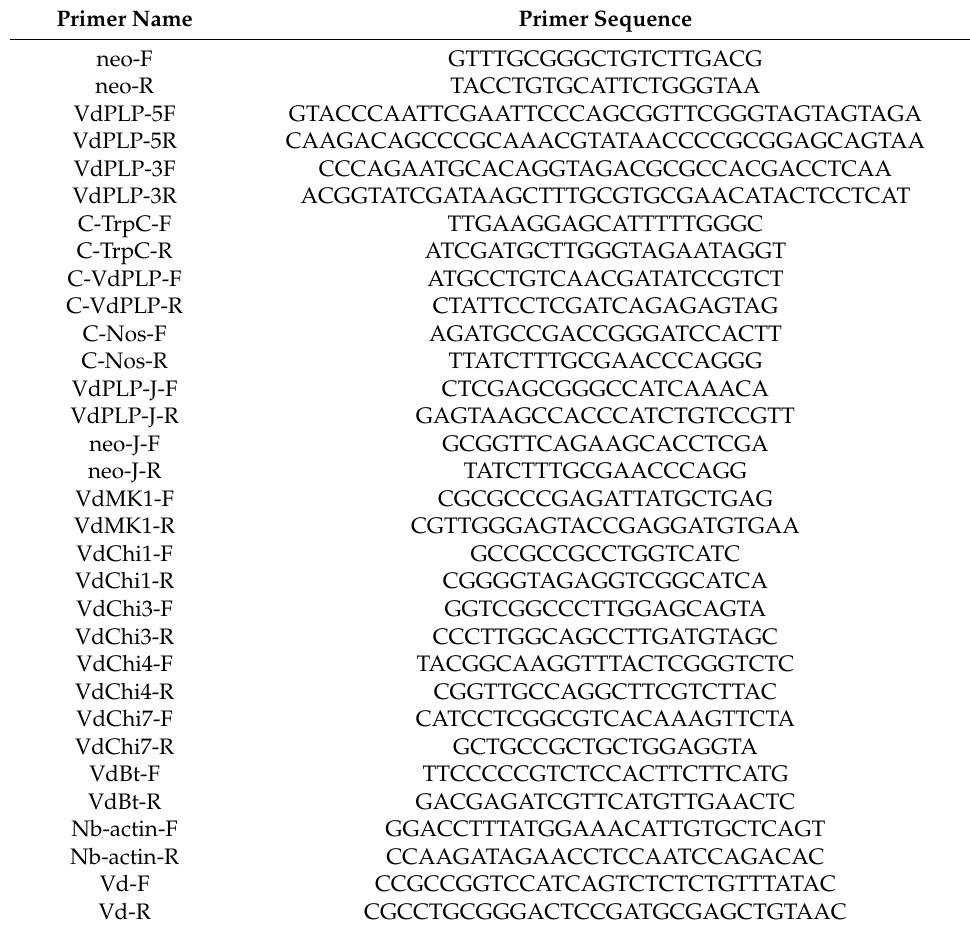
Table 1. List of primers used in this